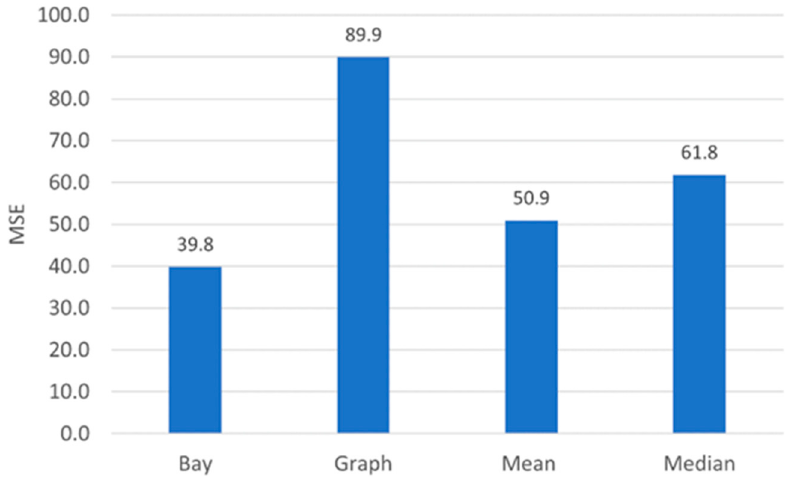
Figure 9. P = 5 metrics, M = 4 sections graph schematically represented in Figure 6. MSE of the Bayesian estimator (Bay), the linear estimate obtained averaging over neighboring graph vertices (Graph), the linear estimate obtained averaging over spatially adjacent vertices (Mean) and the nonlinear estimate obtained as the median over spatially adjacent vertices (Median).